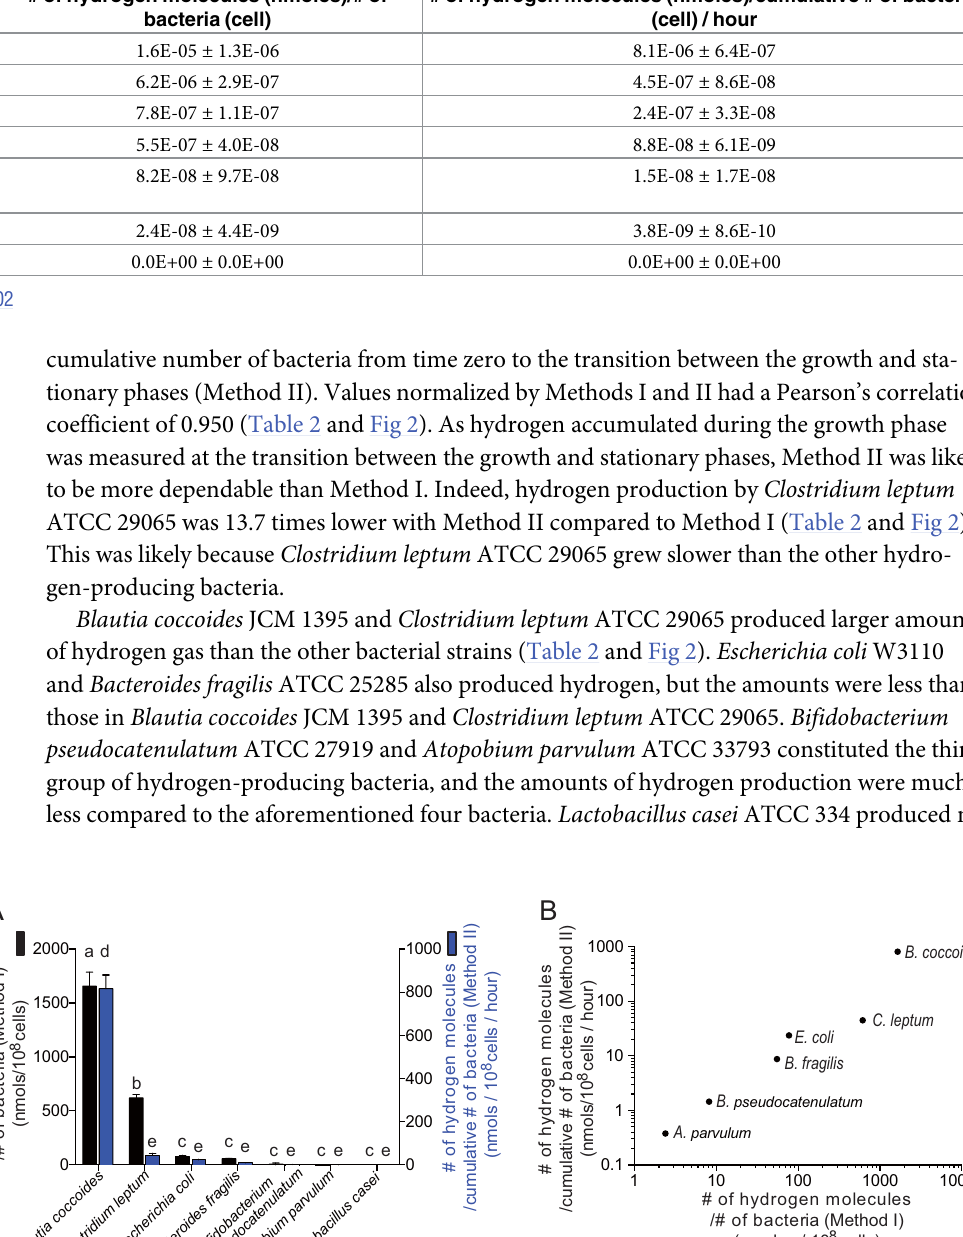
Table 2. The amounts of hydrogen production by seven bacterial strains representing major intestinal bacterial groups/genera/species. Strain